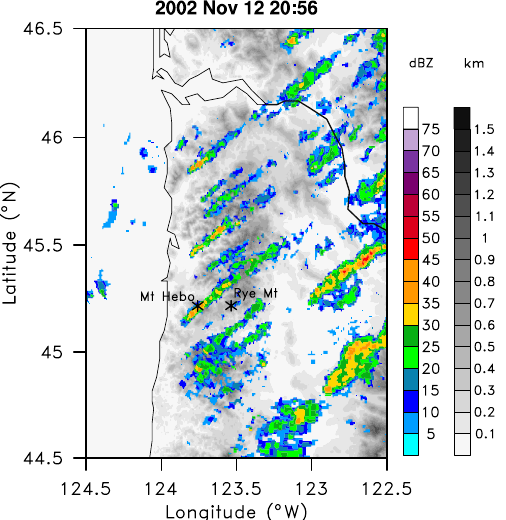
Figure 7. Snapshot of radar reflectivity (color fill) atop Oregon Coastal Range terrain (gray fill) at 20:56 UTC on 12 November 2002, showing organized convective rainbands in postfrontal flow. This same case was studied in detail by Kirshbaum and Durran [46] and Kirshbaum et al.